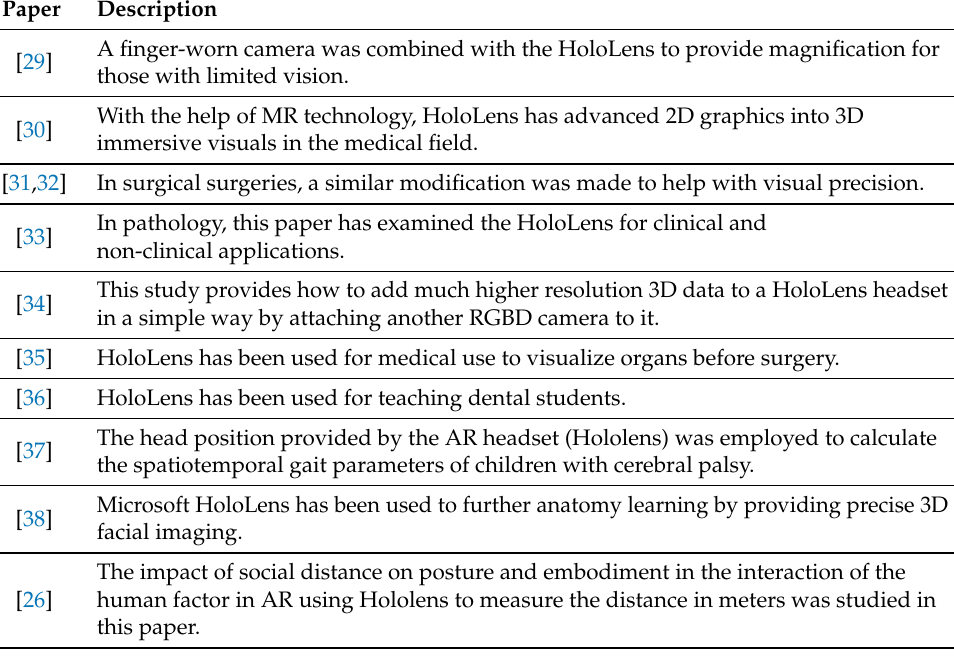
Table 2. Summary of Hololens in The Literature